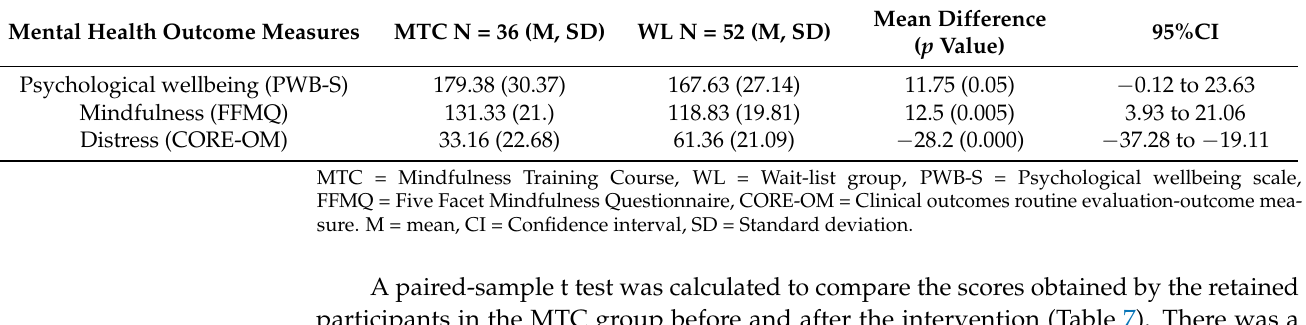
Table 6. Comparison of mental health outcome measures at post